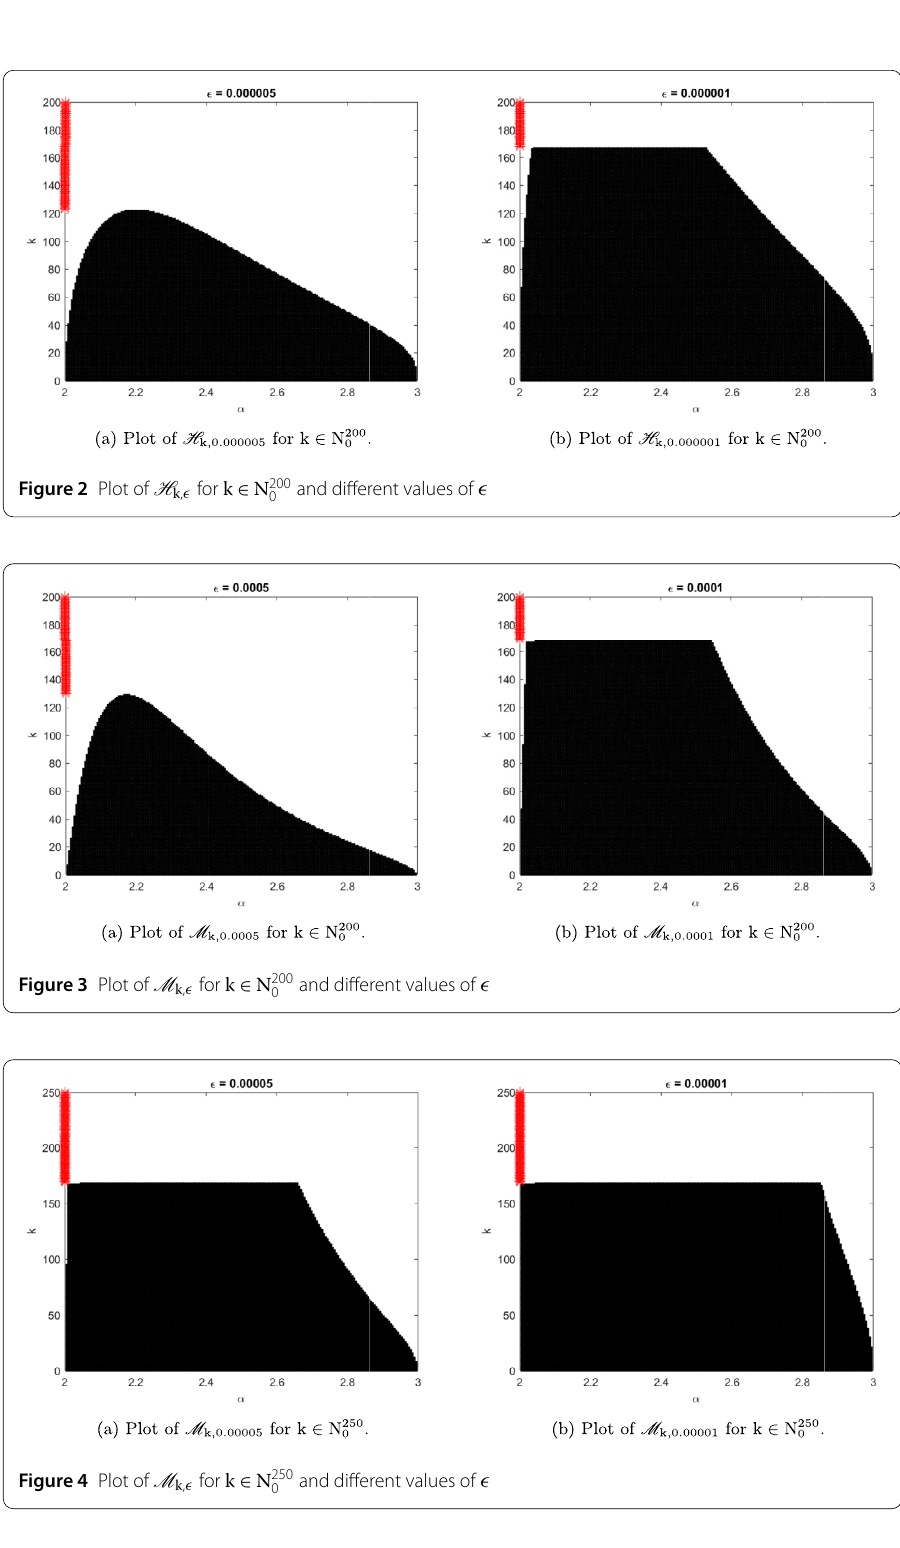
In both Figs. 1 and 2, the set H k, (cid:4) remains empty for less values of k when (cid:4) is larger than when (cid:4) is small. Furthermore, this set arises to be enriched almost surely toward α values closer to 2 than those closer to 3; especially, for α ≈ 2.2, it appears that the set H k, (cid:4) is most